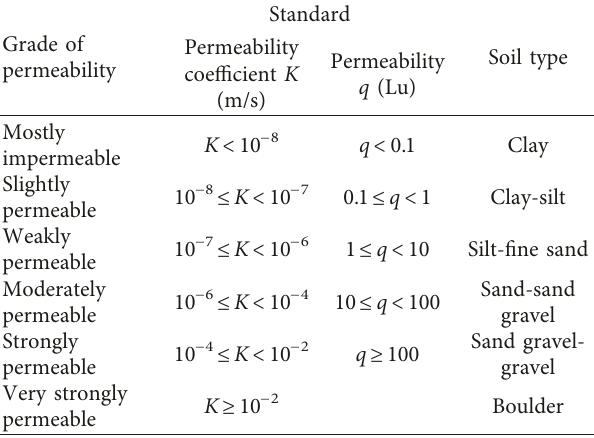
Table 3: Permeability gradation for rock and